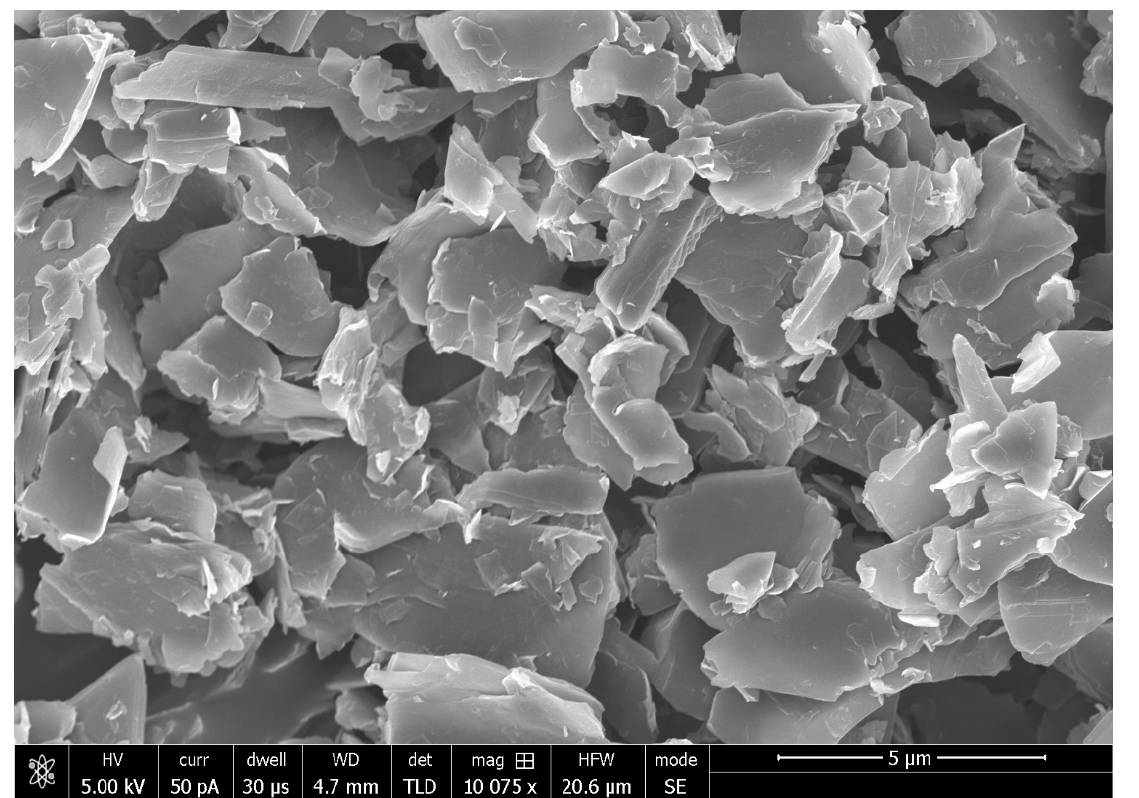
Figure 7. SEM micrograph demonstrating flake-shaped GO particles. Reprinted with permission from Al-Fawaz et al. [54]. Copyright 2020 MDPI.